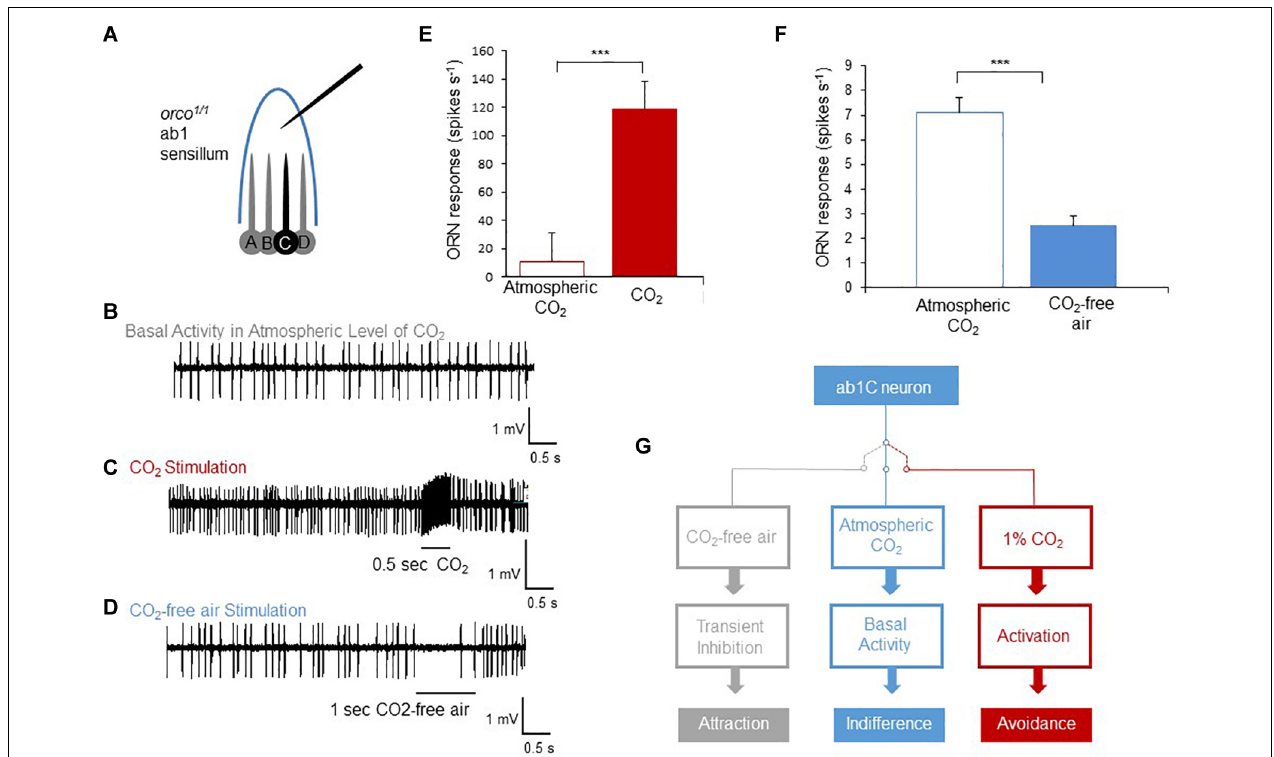
FIGURE 3 | Sub-atmospheric CO 2 pulses cause silencing of spontaneous activity in CO 2 receptor neurons. (A) Diagram of ab1 single sensillum recording of orco 1 / 1 flies. A,B, and D neurons cannot respond to stimulation due to the orco receptor mutation. (B–D) Representative spike traces of spiking activity of ab1C (CO 2 ) neurons’ spontaneous activity (B) , exposed to 1% CO 2 (C) and exposed to CO 2 -free air (D) . (E–F) Summary of activity of the ab1C neuron evoked by CO 2 ( n = 7) and inhibited by CO 2 -free air ( n = 8). The number of generated spikes was significantly reduced when ab1C neurons were exposed to CO 2 -free air compared to pre-stimulation activity ( p < 0.0001, n = 8). Significance assessed by T-test. Error bars represent SEM. (G) Scheme of three activity states of the CO 2 neuron and the corresponding behavioral outputs. When the receptor neuron is not exposed to any stimulus, it produces spontaneous spikes resulting in behavioral indifference. Transient inhibition of spontaneous activity by CO 2 -free air generates attraction. In contrast, activation of the neuron and an increase of spike number cause avoidance behavior as observed for elevated levels of CO 2 . (ns > 0.05, * p ≤ 0.05, ** p ≤ 0.01, *** p ≤ 0.001).